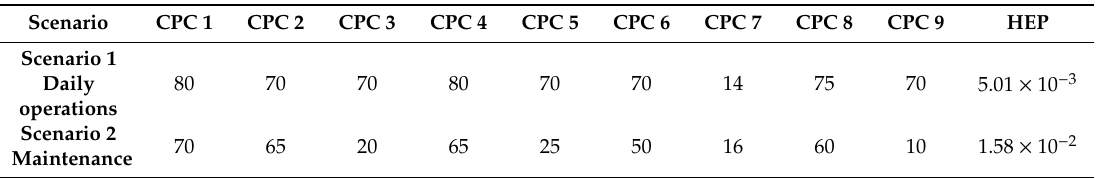
Table 13. HEP estimation through FUZZY